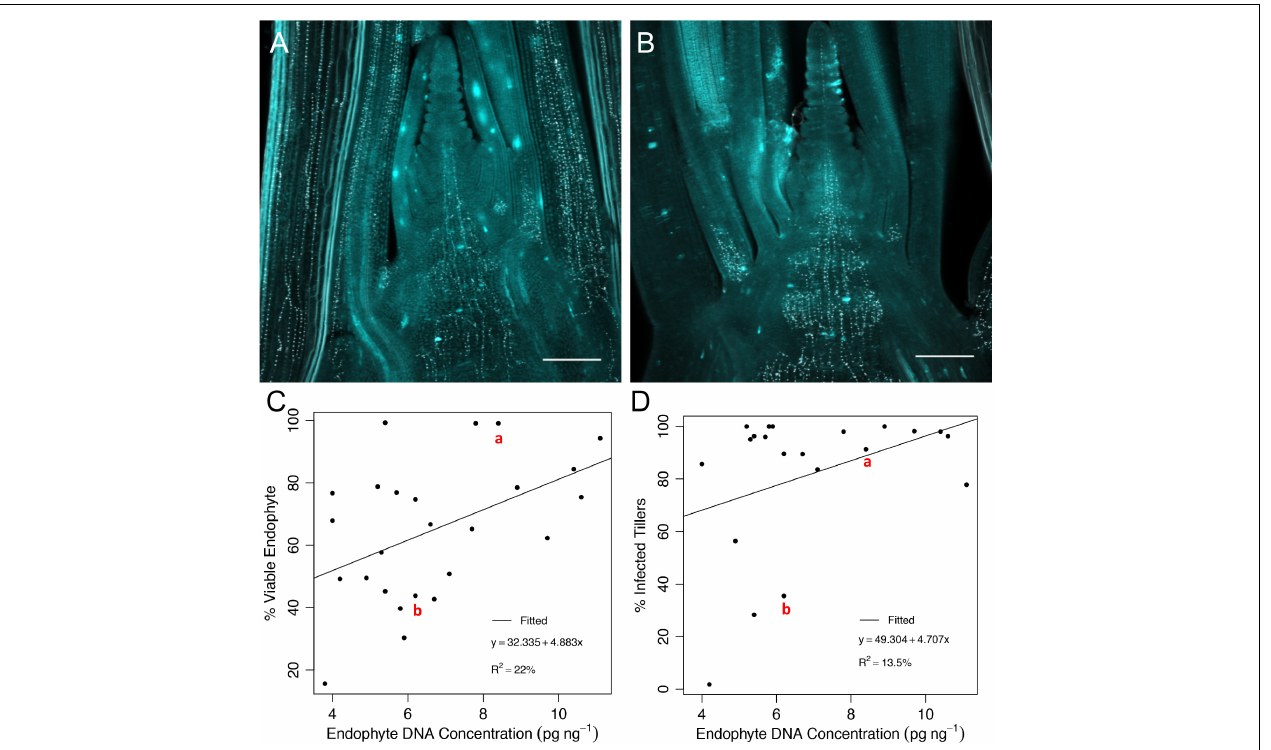
FIGURE 8 | Visualization of endophyte hyphae and hyphal biomass estimates in tiller crown tissues. Confocal microscopy of longitudinal views through the center of tillers showing hyphae in tiller tissues of a representative (A) high-transmitting parental genotype, 107 and (B) low-transmission genotype, 13 of Population IV. The white dots are labeled septa separating adjacent hyphal compartments (WGA-488, false color white), and scale bar represents 0.2 mm. Scatterplots of the % viable endophyte transmission rates (based on seed harvested at the Grasslands Research Centre in 2013) (C) and % tiller infection rates taken in 2016 (D) , relative to endophyte DNA concentration in the shoot apex tissues for a subset of 24 parent plant genotypes from Population IV. Data points for the genotypes shown in panels (A,B) are labeled in